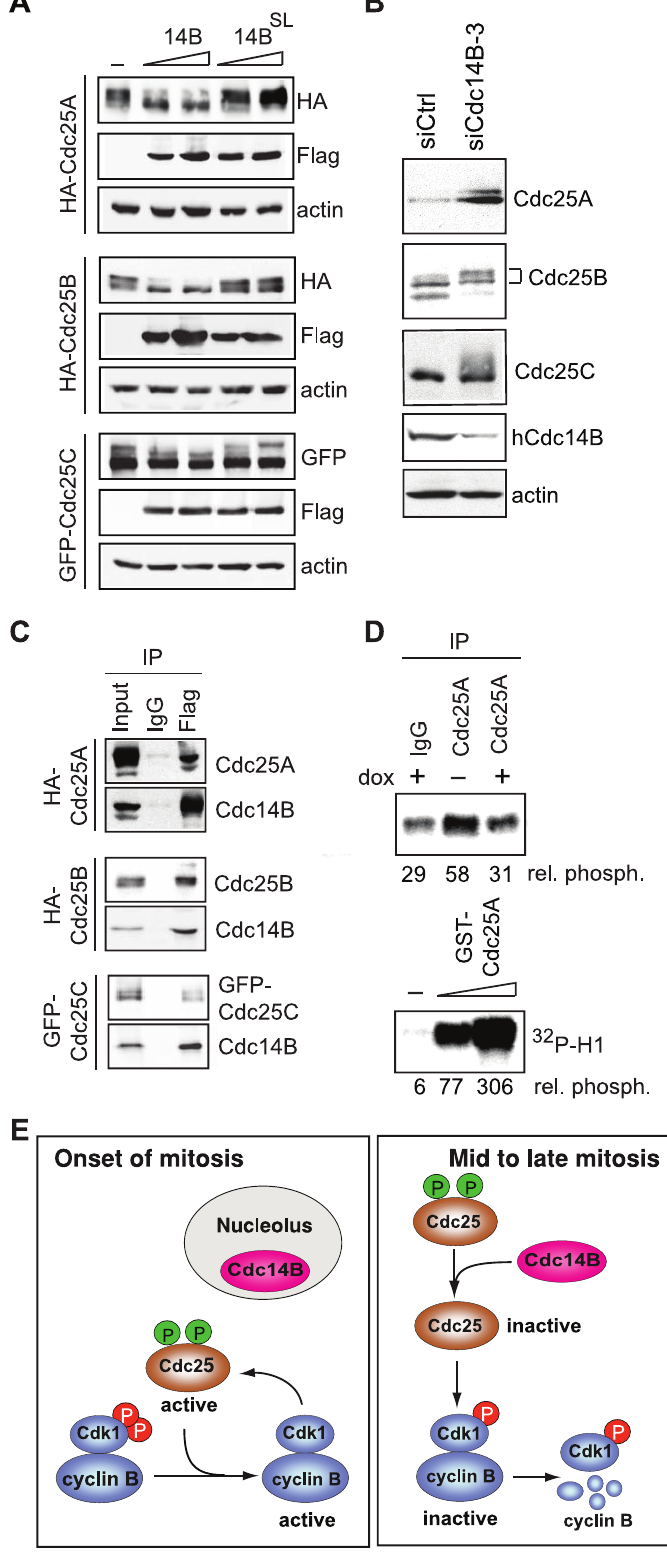
Figure 6. hCdc14B dephosphorylates Cdc25. A . hCdc14B dephosphorylates Cdc25 in vivo . Immunoblots of nocodazole-arrested HEK293T cells co-expressing fl-hCdc14B or fl-hCdc14B SL and HA-Cdc25A, HA-Cdc25B or GFP-Cdc25C. The upper bands correspond to hyperphosphorylated Cdc25 proteins. B . Cdc25 phosphatases are hyperphosphorylated in cells depleted of hCdc14B. HeLa Kyoto cells transfected with control (siCtrl) or hCdc14B-